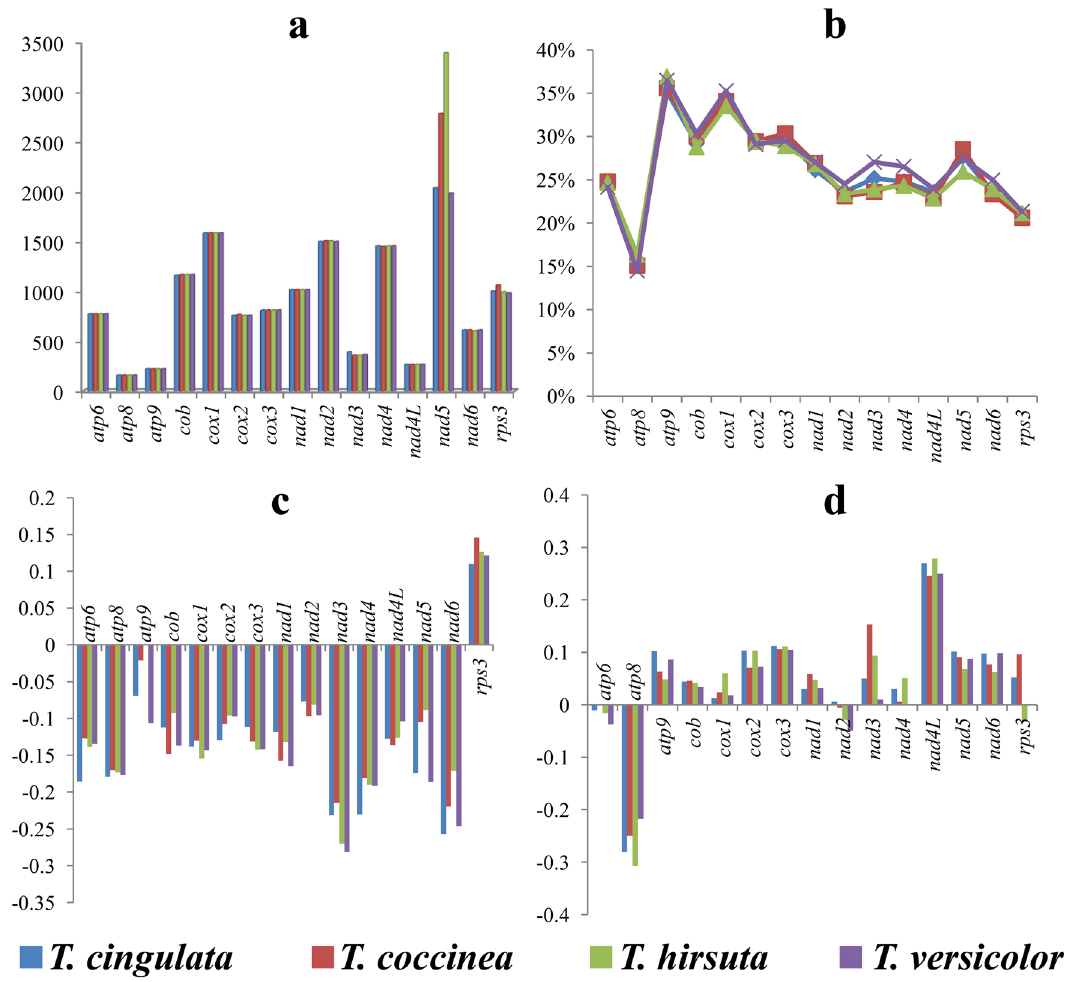
Figure 4. Variation in the length and base composition of each of 15 protein-coding genes (PCGs) between four Trametes mitogenomes. ( a ) PCG length variation; ( b ) GC content of the PCGs; ( c ) AT skew; ( d ) GC